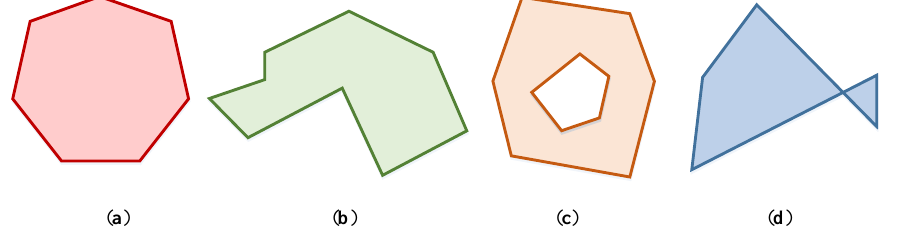
Figure 20. Different types of planar surfaces: ( a ) convex, ( b ) concave, ( c ) hollow, and ( d ) complex surfaces.